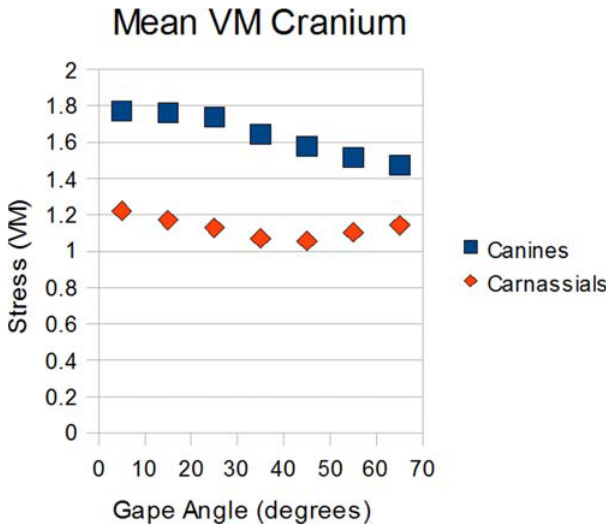
Figure 4. Focus on cranium stress distribution during each freedom